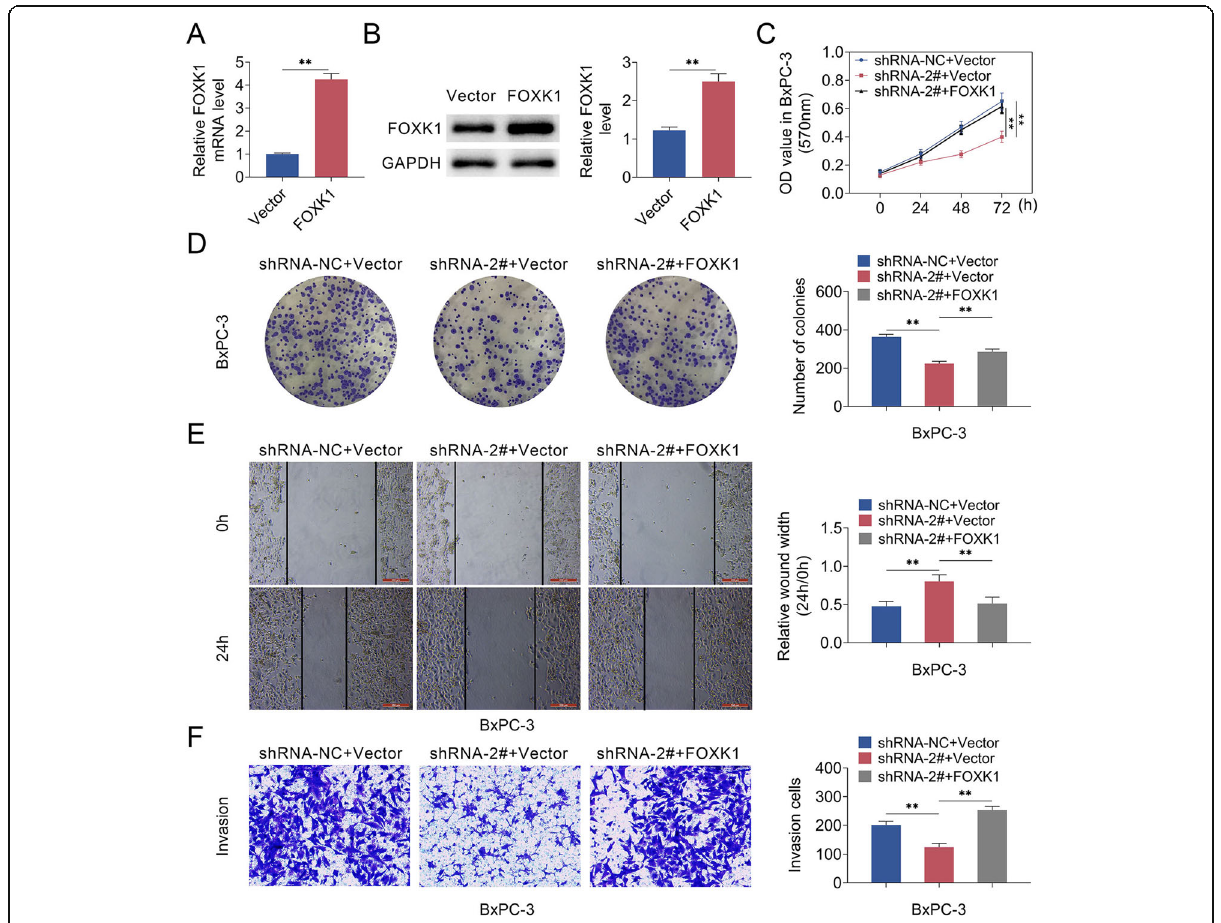
Fig. 6 MCM3AP-AS1 facilitated cell growth and invasion in PC cells by FOXK1. a qRT-PCR and western blot analysis showed the FOXK1 level. c Cell proliferation was detected via MTT assay. d Clone formation assay was used to detect the clone formation ability. e - f Cell invasion and migration were testified using Transwell assay and wound healing assay. Scale bar, 50 μ m. n = 3. (**, p <